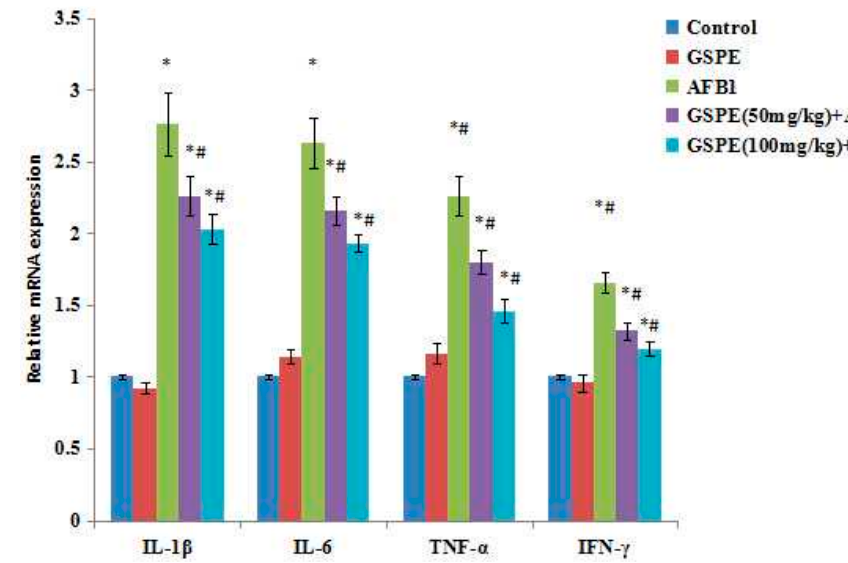
Figure 4. Effect of AFB1, GSPE and their co-treatment on interleukin 1 β (IL-1 β ), IL-6, tumor necrosis factor α (TNF- α ), and interferon γ (IFN- γ ) relative mRNA expression in spleen of mice. Values are mean ± SEM of ten mice in each group. ǂ p < 0.05 vs. control group, # p < 0.05 vs. AFB1 treated group.